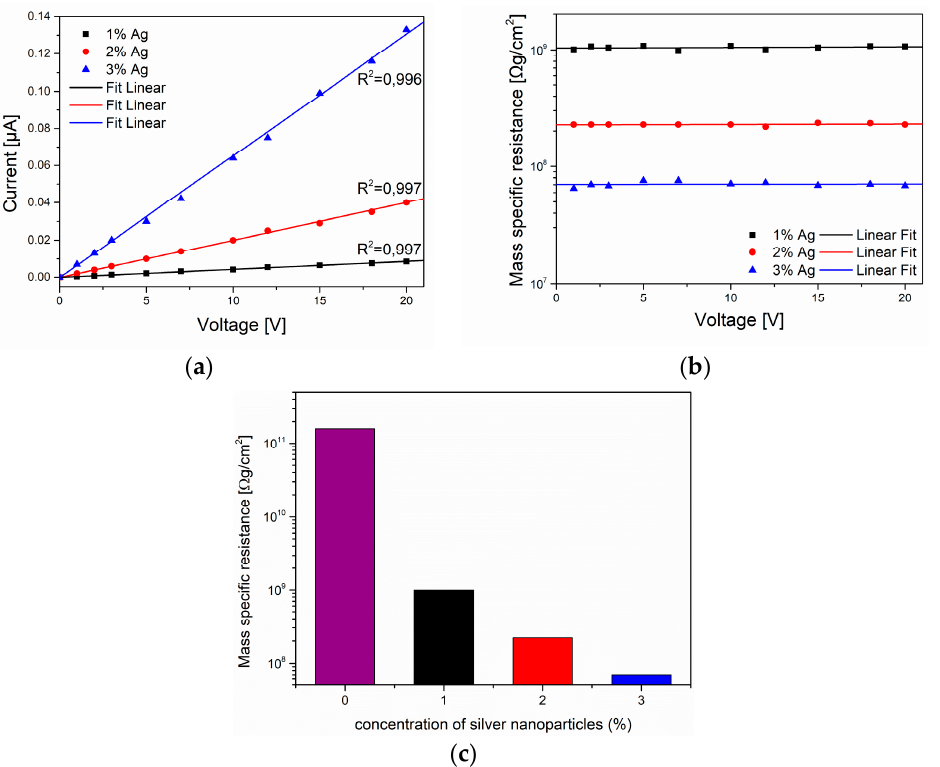
Figure 9. Electric parameters of PAN fibers as a function of the silver nanoparticle concentration: ( a ) current–voltage characteristics; ( b ) change in mass resistance as a function of voltage, ( c ) mass resistance as a function of silver concentration.